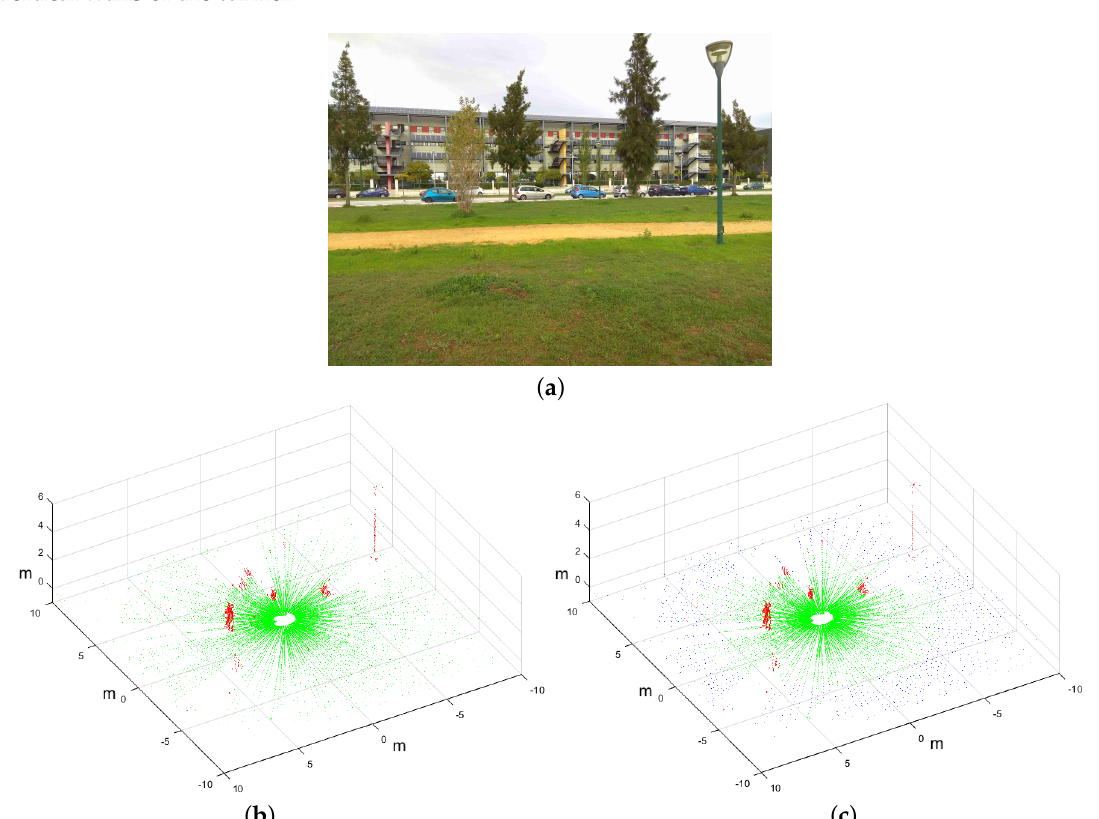
Figure 9. A photograph of a park ( a ) and a real 3D point cloud from Andabata manually-tagged ( b ) and classified with RF ( c